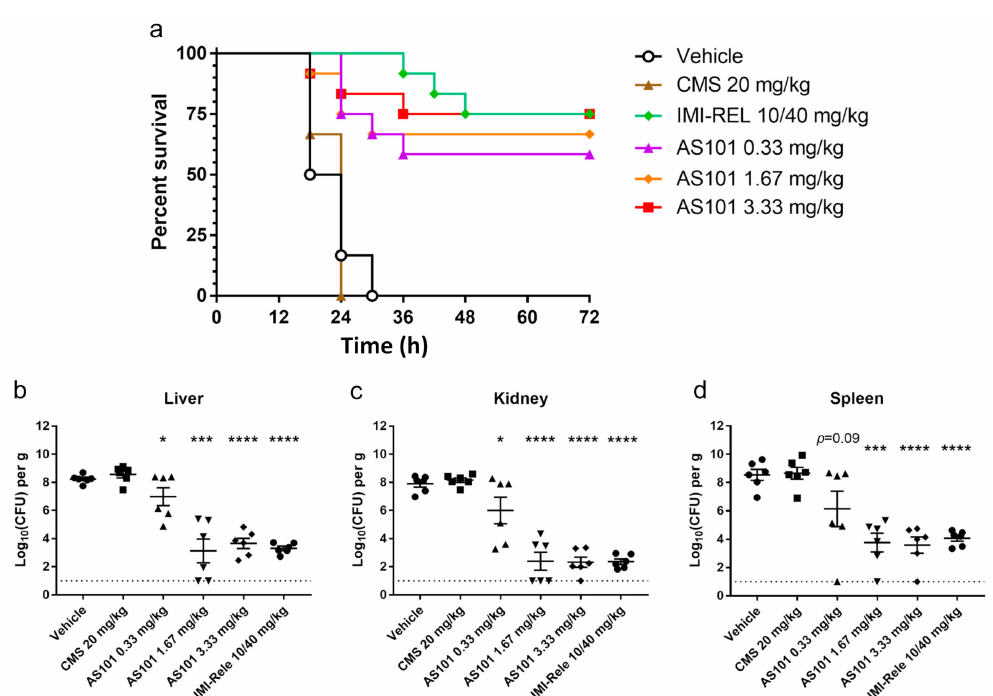
Figure 5. Lethally infected mice rescued by AS101 treatment. ( a ) CD-1 mice ( n = 12 per group) were intraperitoneally injected with lethal challenges of the colistin-resistant CRKP isolate, CRE-723, and treated with 1 × of a PBS vehicle, 20 mg/kg colistin methanesulfonate (CMS), 10/40 mg/kg imipenem-relebactam, or AS101 at various dosages. Infected mouse viabilities were observed as 0% (0/6) for the vehicle treatment; 0% (0/12) for 20 mg/kg CMS; 58.8% (7/12) for 0.33 mg/kg AS101; 66.6% (8/12) for 1.67 mg/kg AS101; 75% (9/12) for 3.33 mg/kg AS101; and 75% (9/12) for 10/40 mg/kg imipenem-relebactam. For organ load experiments, animals were intraperitoneally challenged with lethal doses of the colistin-resistant CRKP isolate, CRE-723, and euthanized 18 h post-infection. Bacterial counts in ( b ) livers, ( c ) kidneys, and ( d ) spleens were determined by plating. Dotted lines indicate detection limits. Data expressed as mean ± SD. * p < 0.05; *** p < 0.001; **** p <